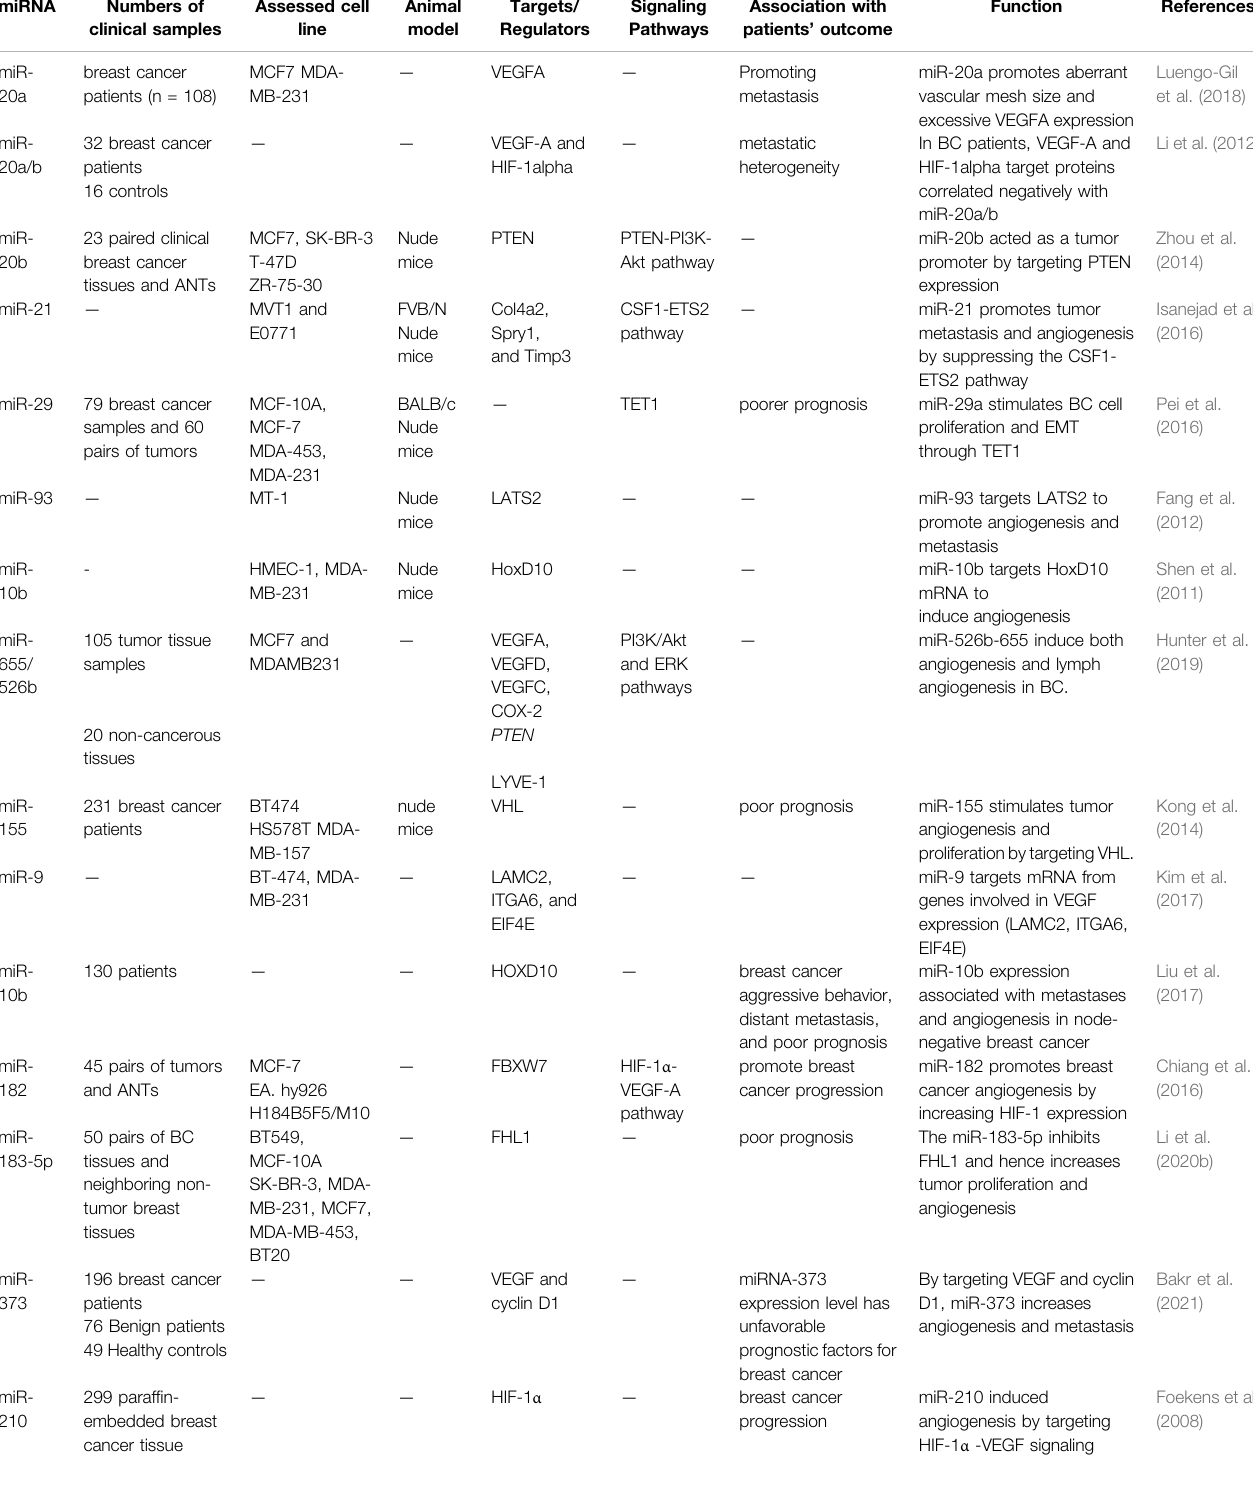
TABLE 2 | miRNAs that promote angiogenesis in Breast cancer (ANTs: adjacent non-cancerous tissues). miRNA Numbers of clinical